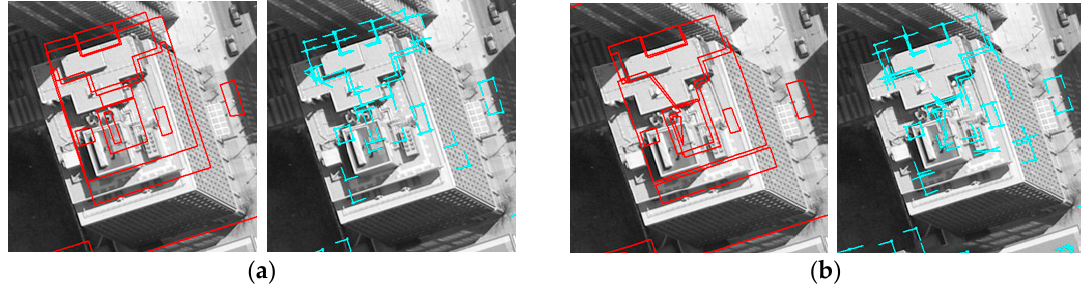
Figure 10. Features from existing building models: ( a ) manually digitized building models and their edged corner features and ( b ) LiDAR-driven building models and their edged corner features.